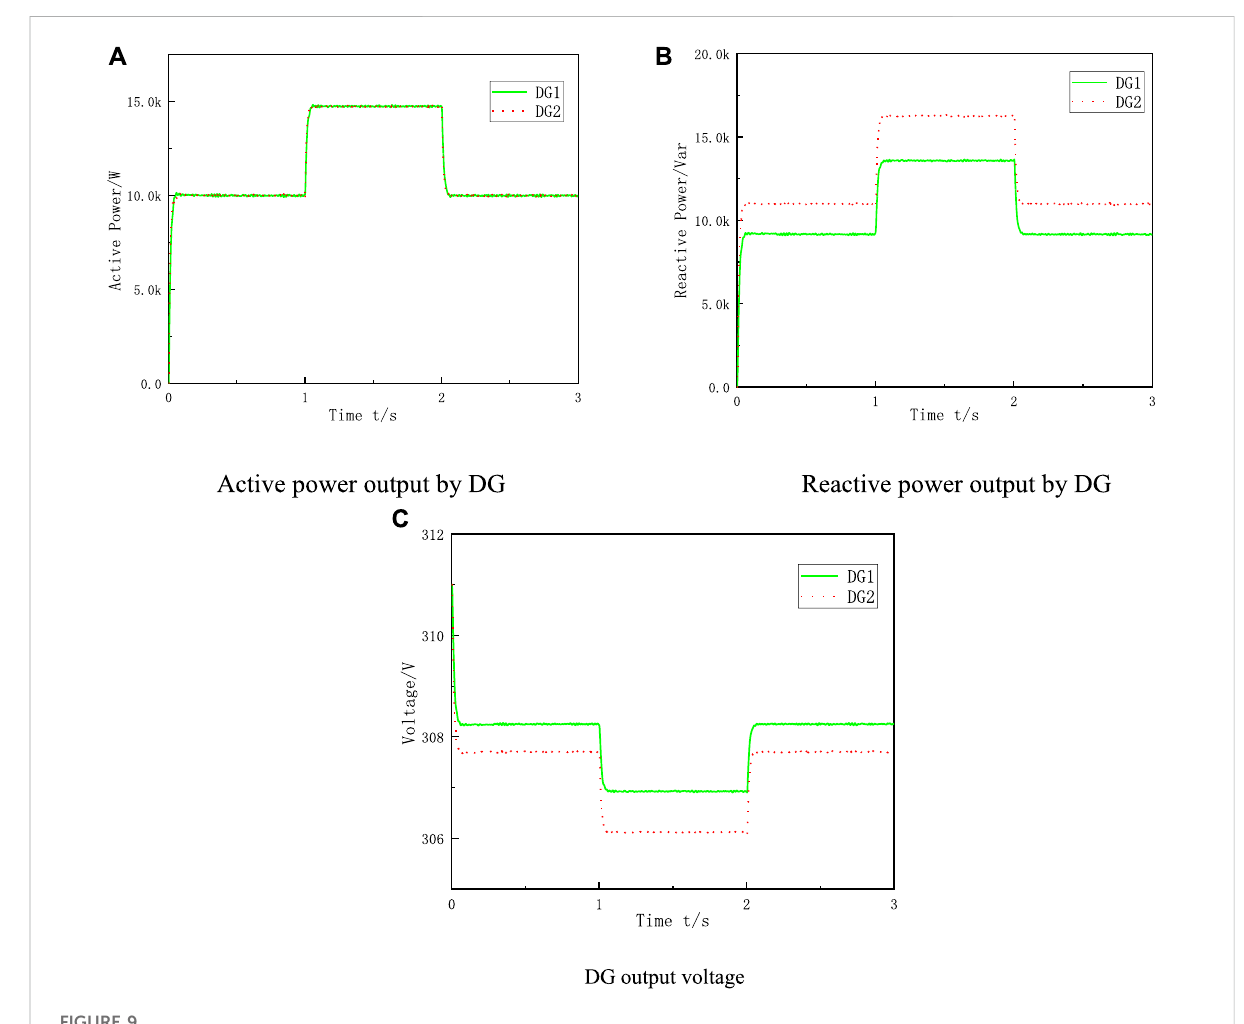
Figure 7 is the direction in which the corresponding parameter